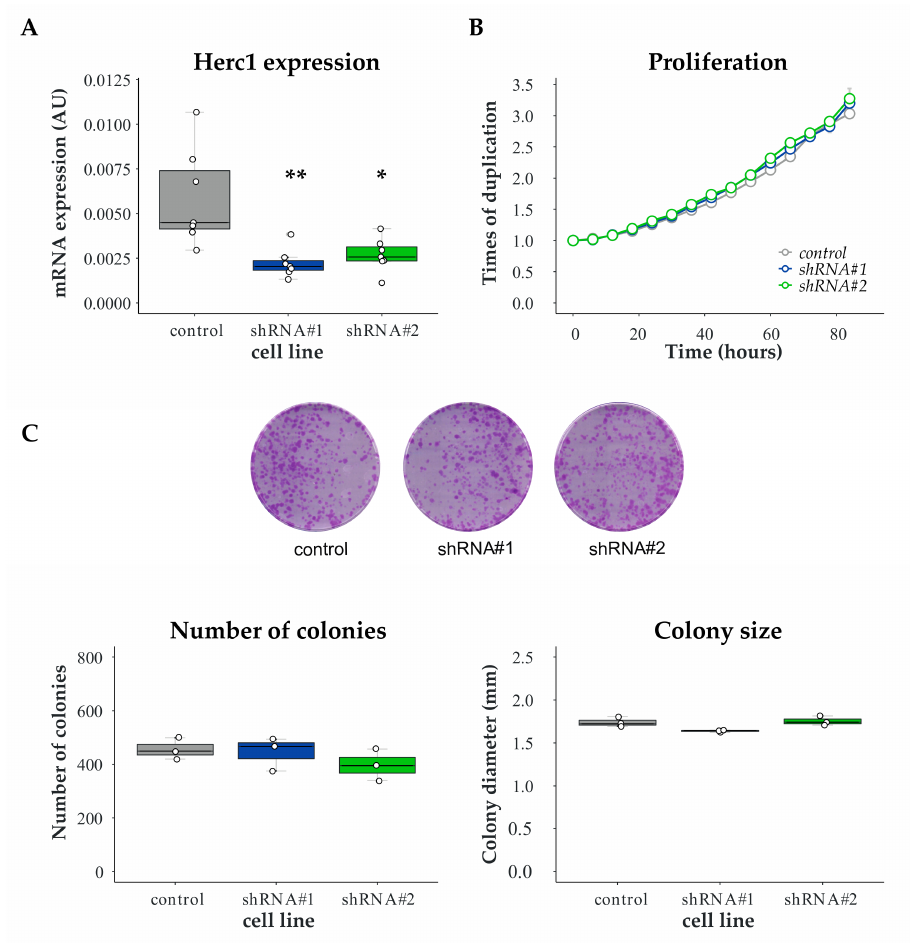
Figure 2. Proliferation is unaffected by HERC1 depletion. MDA-MB-231 cells were stably transduced with an empty vector (control) or two different shRNAs (#1 and #2) targeting HERC1. ( A ) Efficiencies of shRNA-mediated target gene knockdown were confirmed by RT-PCR (top, n = 7, one-way ANOVA, Dunnett’s multiple comparison test; shRNA #1 p = 0.0014 (**) and shRNA #2 p = 0.0365 (*)). ( B ) An area- based microscopy method was used to determine cell growth over time. Cells were seeded onto wells and allowed to attach. At the indicated time points, cells were photographed, and the occupied area was calculated. The graph shows the occupied area relative to time = 0 h. Doubling times = control, 47.01 ± 0.2087; shRNA #1, 46.23 ± 0.3667; shRNA #2, 47.38 ± 1.023 ( n = 3, Kruskal–Wallis, Dunn’s multiple comparison test; shRNA #1 p > 0.9999 and shRNA #2 p = 0.4503). ( C ) Cells were subjected to colony formation assay: (Top) representative images of the crystal violet-stained 100 mm dishes at the end of the experiment; (Bottom Left) number of colonies generated after 15 days ( n = 3, Kruskal– Wallis, Dunn’s multiple comparison test; shRNA #1 p > 0.9999 and shRNA #2 p = 0.4661); and (Bottom Right) diameter of the resulting colonies ( n = 3, Kruskal–Wallis, Dunn’s multiple comparison test; shRNA #1 p = 0.1473 and shRNA #2 p >